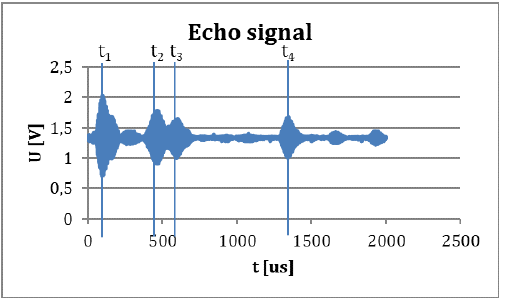
Figure 1. A measured echo signal in a one-sensor ultrasound measurement. The detected four objects’ four traveling times are marked (t1, t2, t3, t4) on the measured signal.